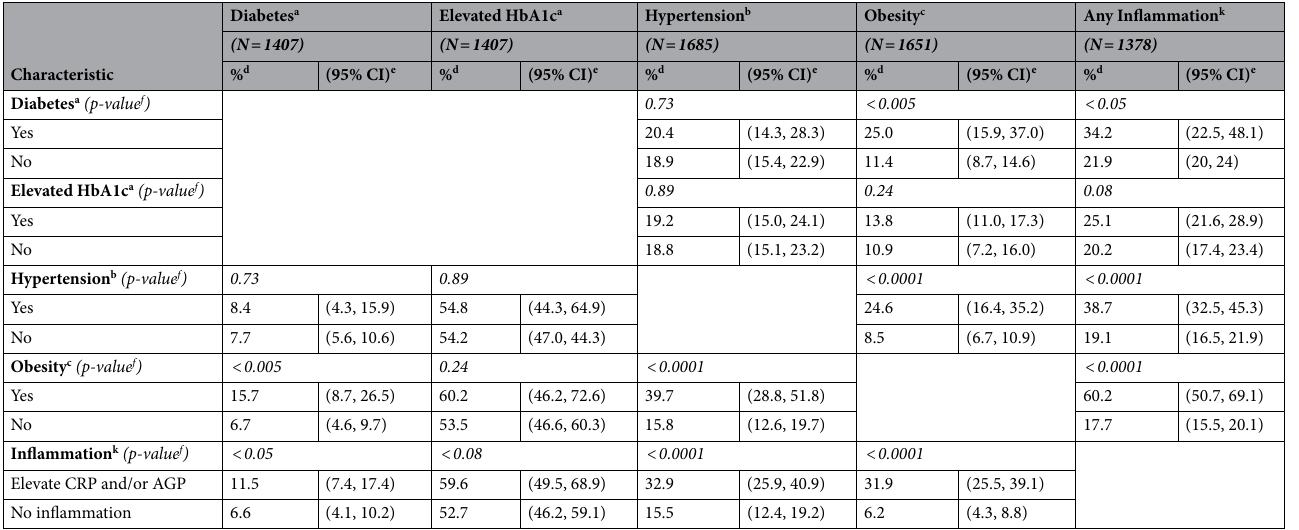
Table 3. Associations between different cardio metabolic risk factors in non-pregnant women, The Gambia, 2018. a Diabetes defined as glycated hemoglobin (HbA1c) ≥ 6.5% and elevated HbA1c as HbA1c ≥ 5.7% b Hypertension defined as systolic blood pressure of ≥ 140 mmHg and/or a diastolic blood pressure of ≥ 90 mmHg c Obesity defined as body mass index (BMI) of ≥ 30 kg/m 2 , respectively d Percentages weighted for non-response and survey design e CI = confidence interval, adjusted for cluster and stratified sampling design f Chi-square p-value < 0.05 indicates that the proportion between the subgroups is statistically significantly k Any inflammation defined as CRP > 3 mg/L and/or AGP > 1